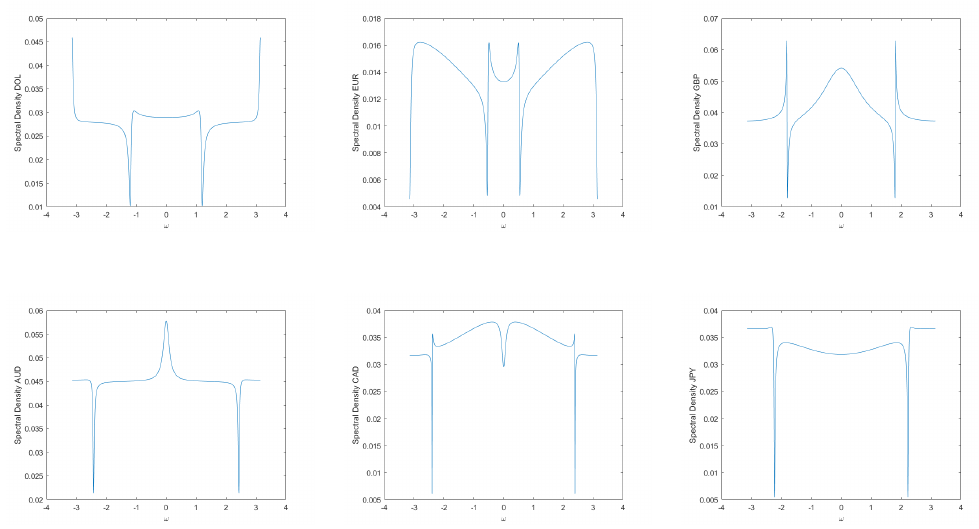
Figure A1. Power spectral density functions of the Majors.